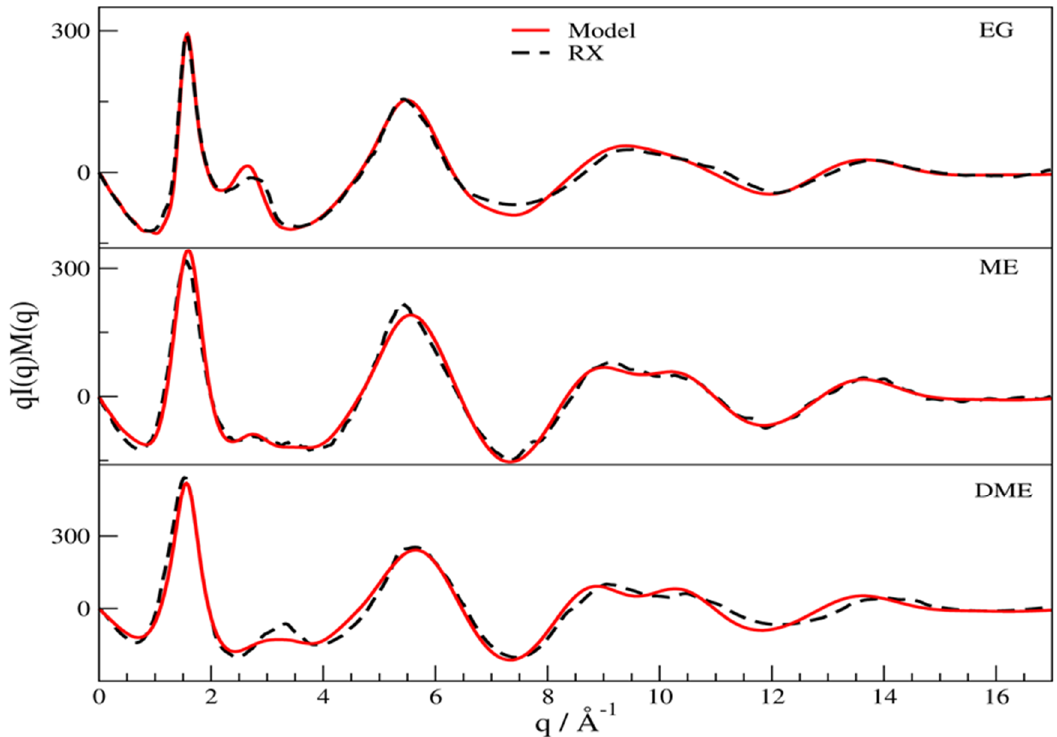
Figure 2. Measured (black dash) and simulated (red line) X-ray structure factors. EG: top panel, ME: middle panel; DME: bottom panel.